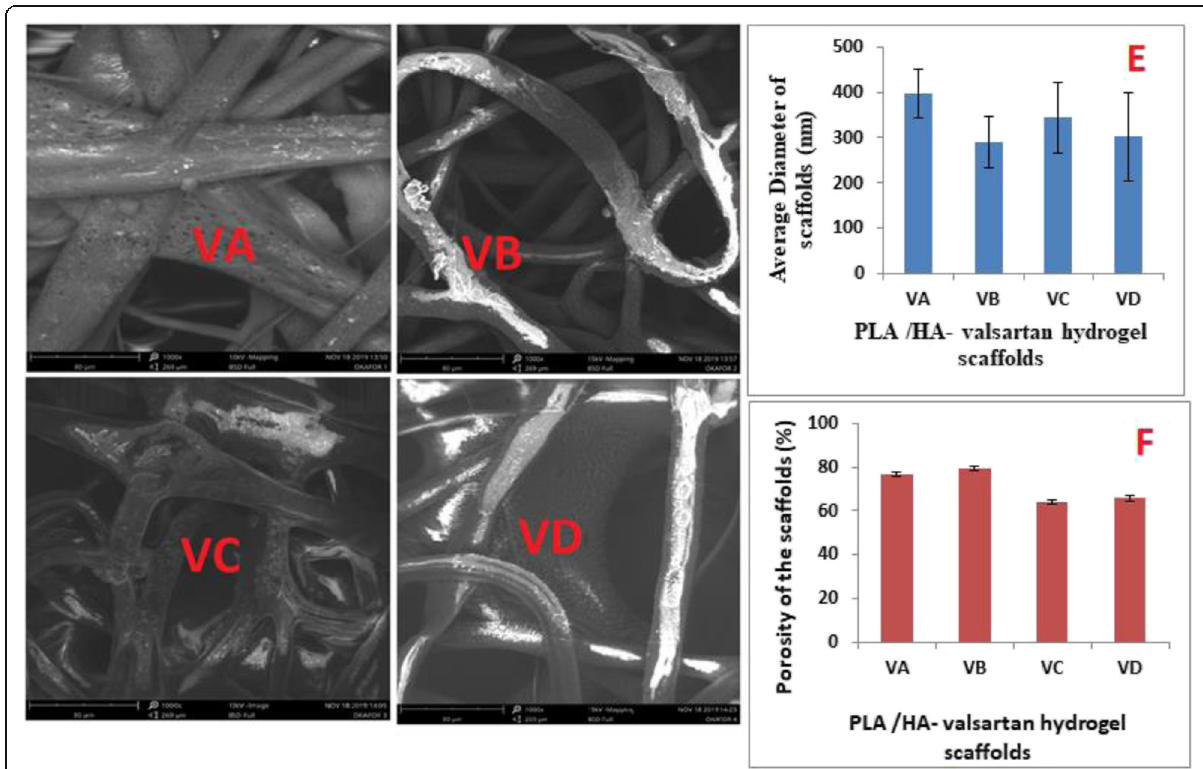
Fig. 2 Scanning electron microscopy of the PLA/HA-valsartan hydrogel scaffold VA, VB, VC, and VD. E Average diameter of the scaffolds. F Percentage porosity of the